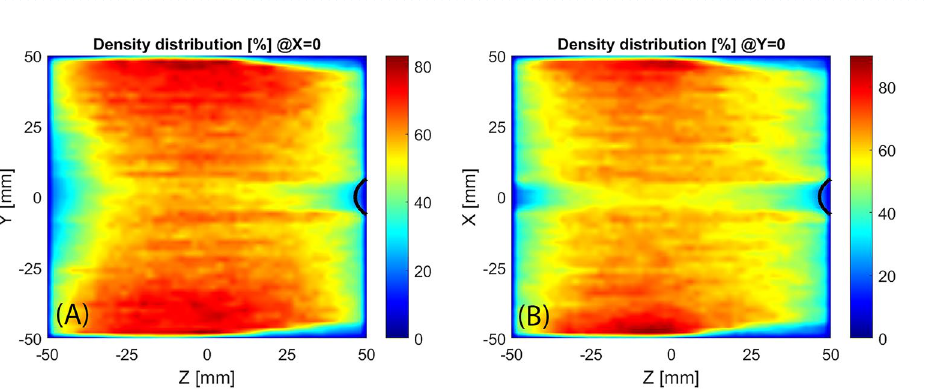
Figure 8. Longitudinal sections of electron density, black line marks the ECR